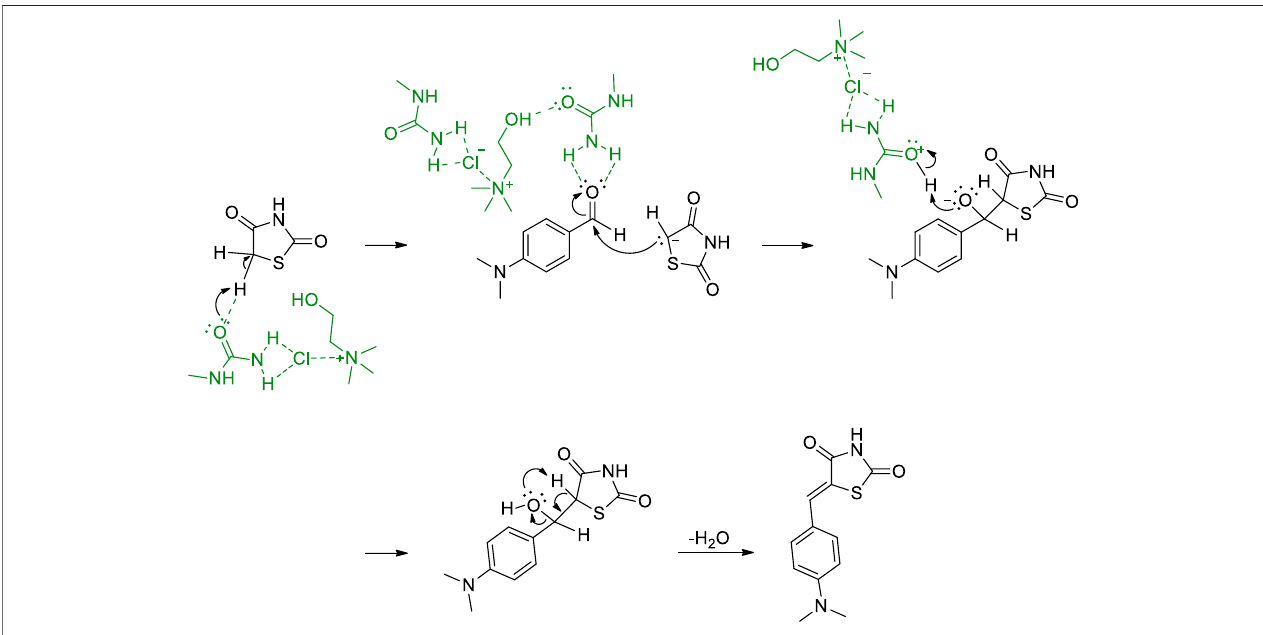
FIGURE 1 | Proposed mechanism of Knoevenagel condensation for the synthesis of thiazolidinedione derivatives in DES..